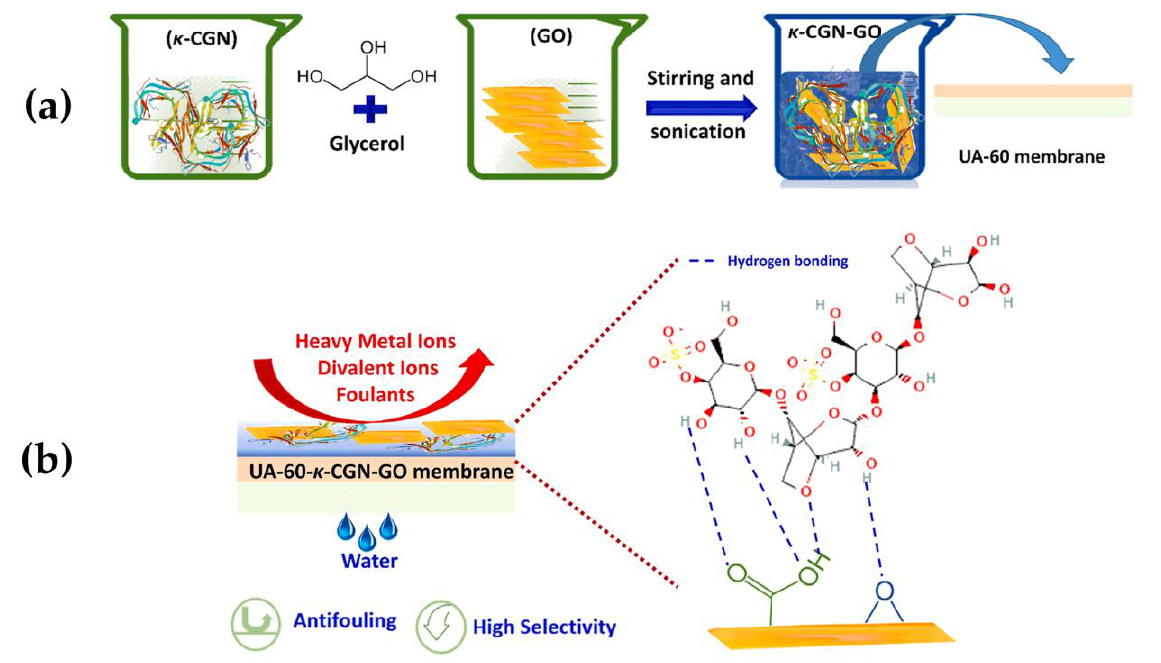
Figure 8. Steps for the preparation of the κ -CGN/GO composite-coated UA-60 loose nanofiltration membrane ( a ) and representation of the possible intermolecular hydrogen bonding through GO and κ -CGN with the properties and application of the final coated membrane ( b ). Reproduced with permission from Journal of Membrane Science; published by Elsevier, 2022 [125].